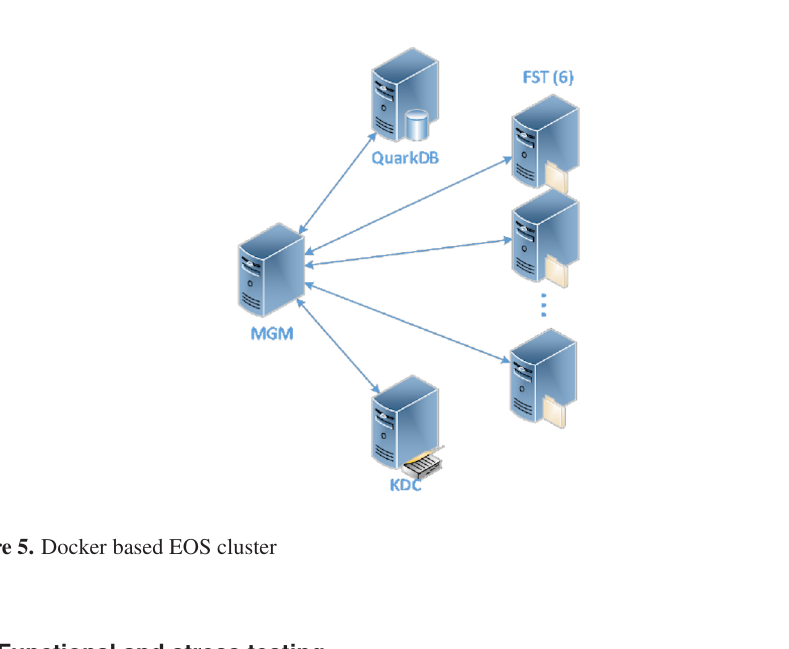
Figure 3. EOS Sonar details